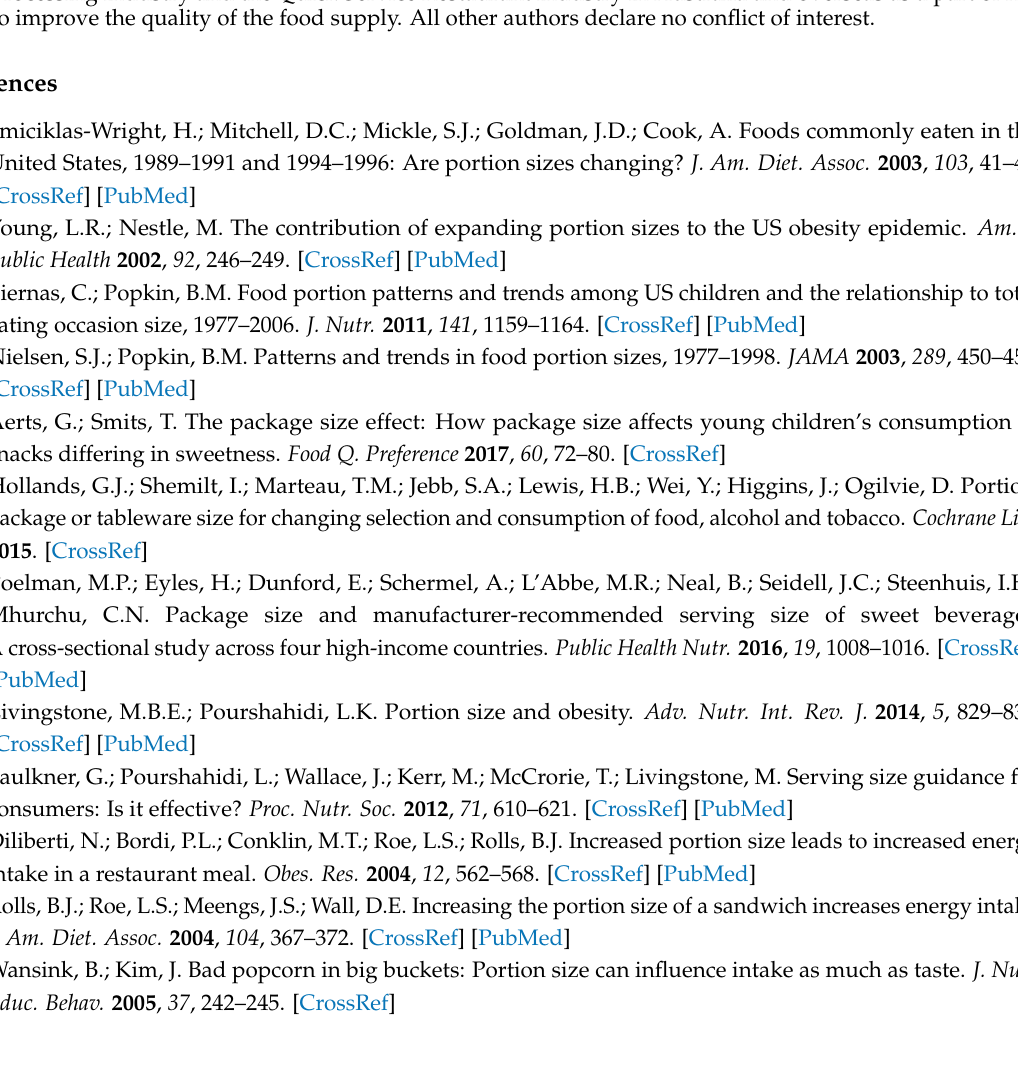
Table S1: Estimated effects of package size cap and energy reduction interventions on the 2010 Australian population over their